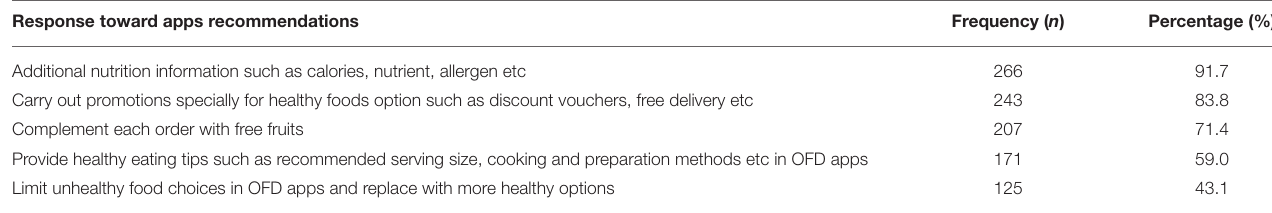
TABLE 9 | Subjects’ responses toward apps recommendations to promote healthier food